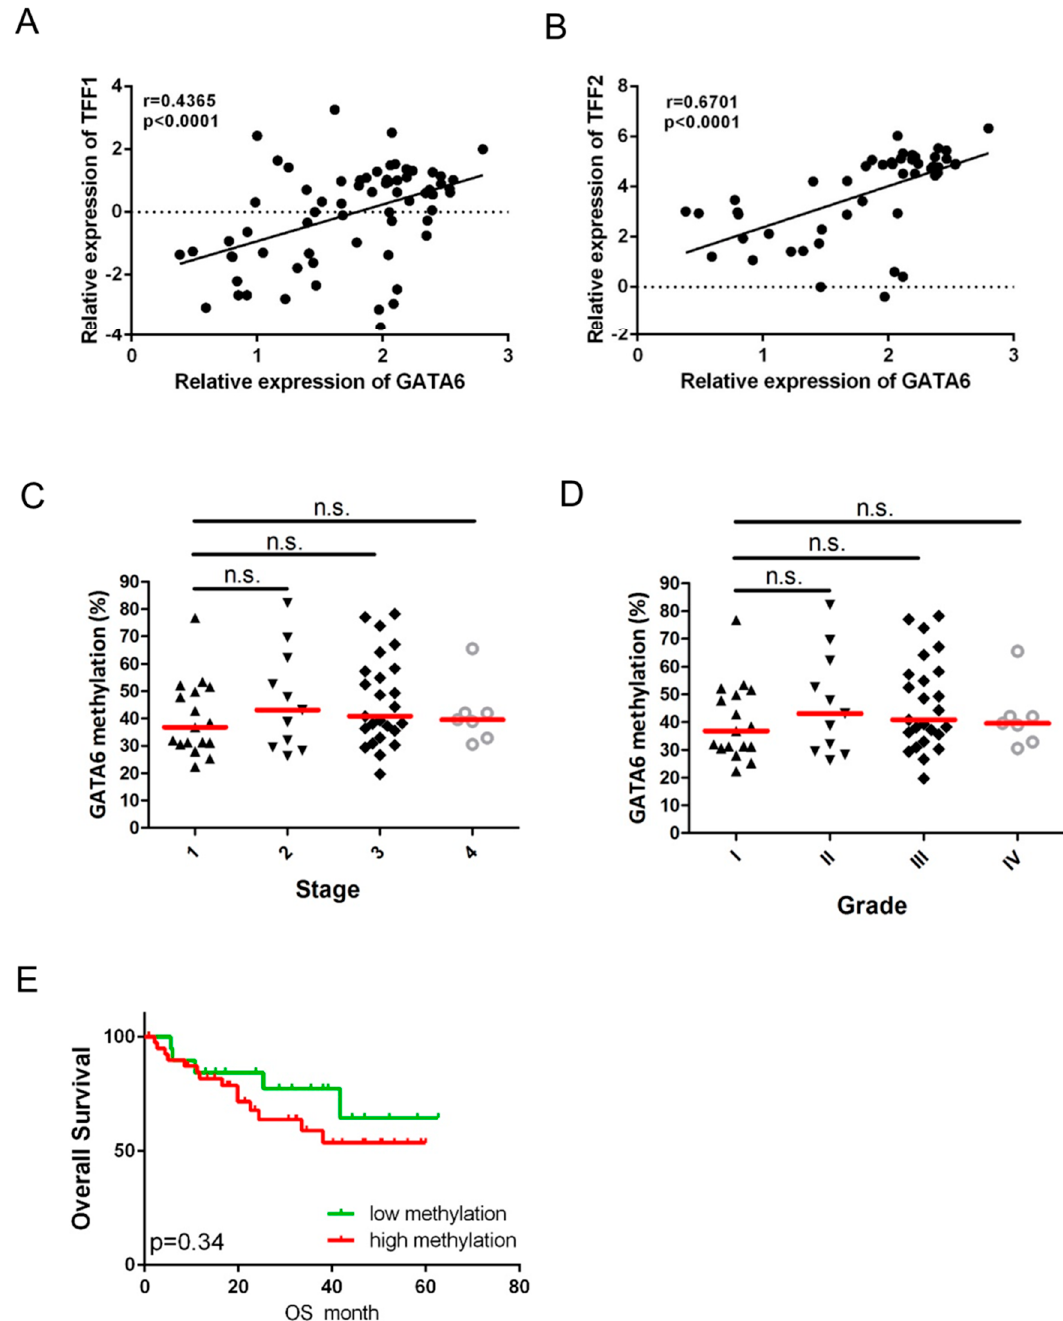
Figure 4. Promoter methylation of GATA6 is frequently observed in gastric cancer patients. Scatter plots showing the correlation between the expression of GATA6 and ( A ) TFF1 and ( B ) TFF2 among 60 gastric cancer patients. A significant correlation was observed between GATA6 and TFF1/2 . The dot plot shows the relationship between methylation level of the GATA6 promoter and ( C ) tumor stage or ( D ) tumor grade among 60 patients with gastric cancer; ( E ) Results from a Kaplan–Meier analysis which show that gastric cancer patients with higher GATA6 methylation (red line, >35% methylation, see Materials and Methods) tended to have shorter overall survival than did patients with lower GATA6 methylation (green line). OS: overall survival. n.s.: not significant.